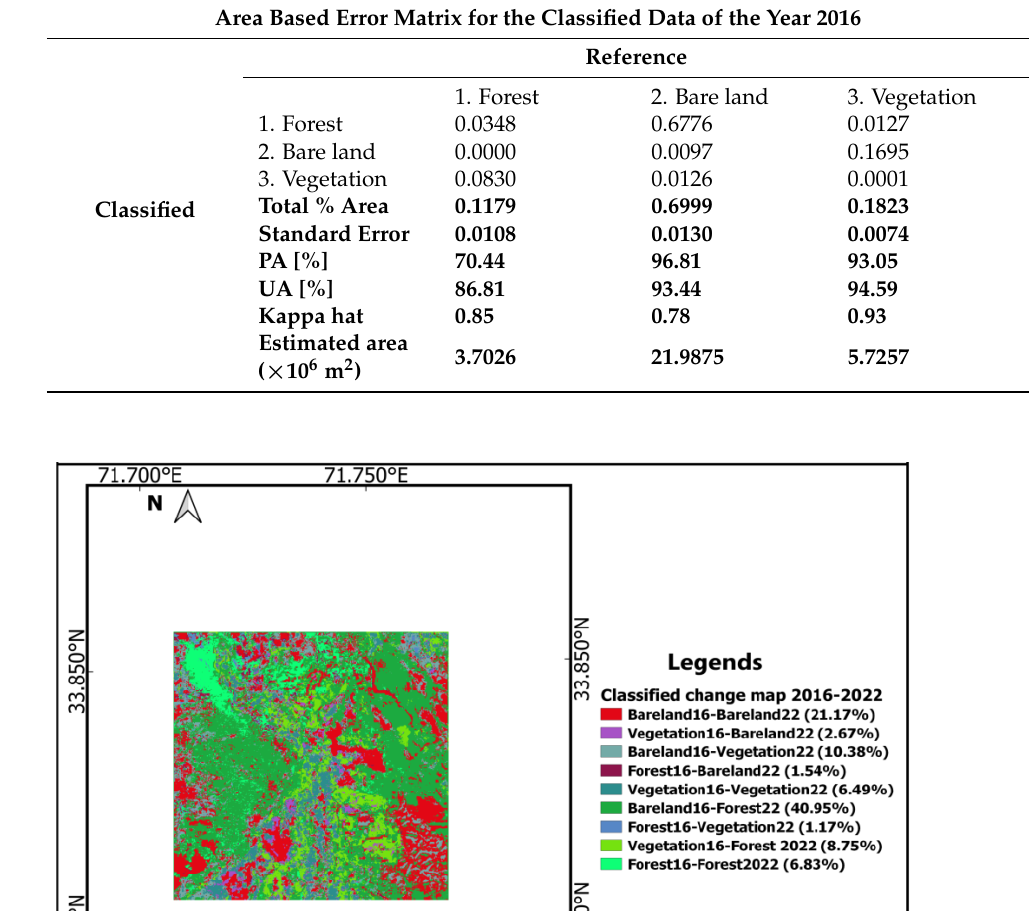
432 Table 14. Accuracy assessment parameters for the classified data of the year 2016. Area Based Error Matrix for the Classified Data of the Year 2016